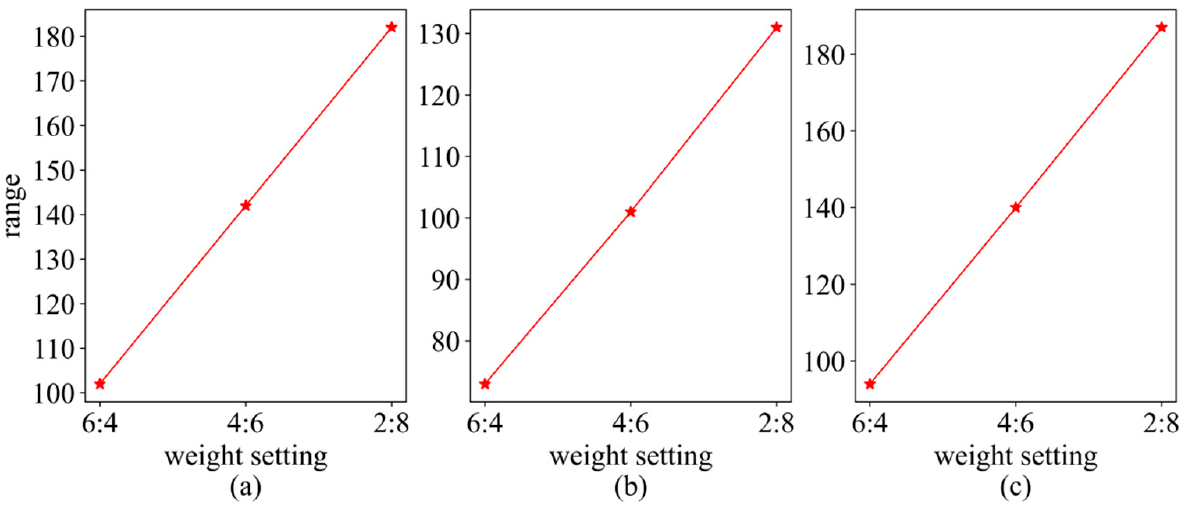
Figure 9. Range of values of pixels on the selected “line”: ( a ) the range on the 14th row of the image of Landsat TM; ( b ) the range on the 19th row of the image of Landsat ETM+; ( c ) the range on the 27th row of the image of Landsat OLI.